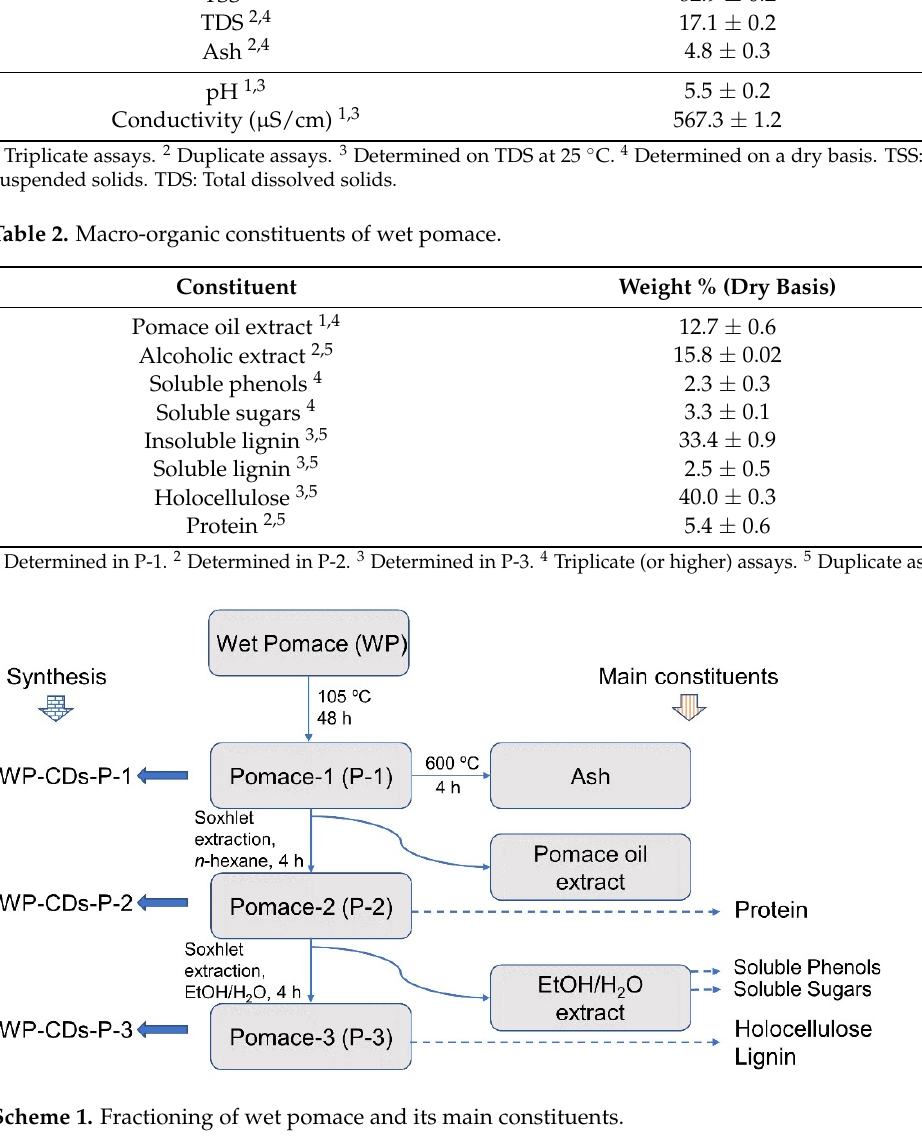
Table 1. Physico-chemical properties of wet pomace.